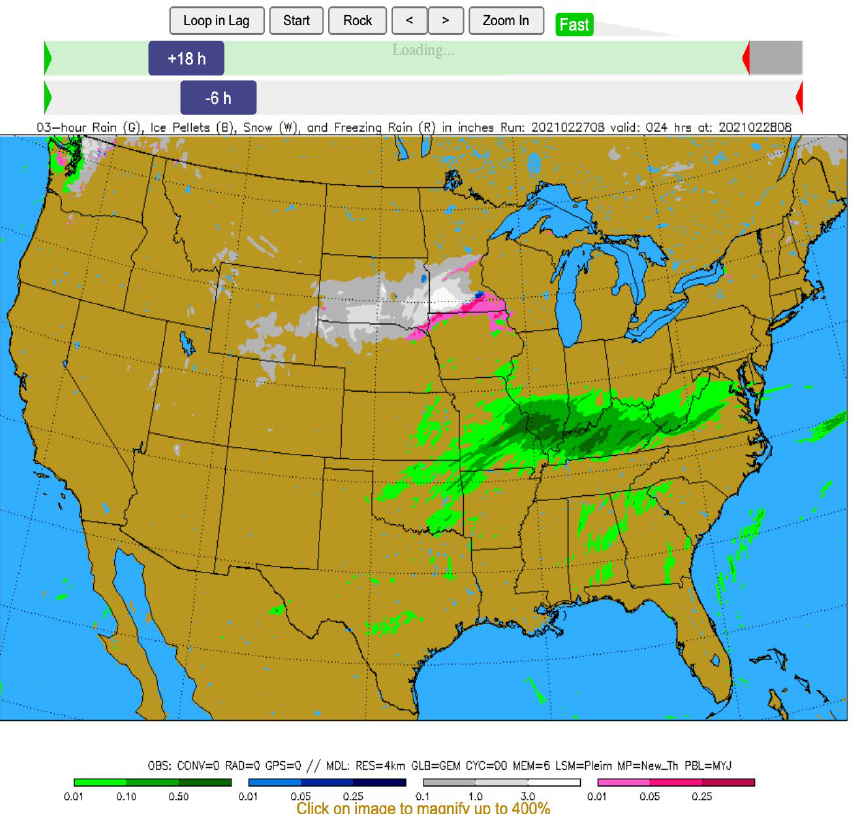
Figure 17. An example of the USAF “Stamp Chart” where instead of each member being laid out like postage stamps, a double-slider bar is used where the top looper displays all ensemble members valid at the selected time. In this example a “Rolling” ensemble member from a 6-hour old cycle is displayed valid 18 hours into the future, relative to the most current run.